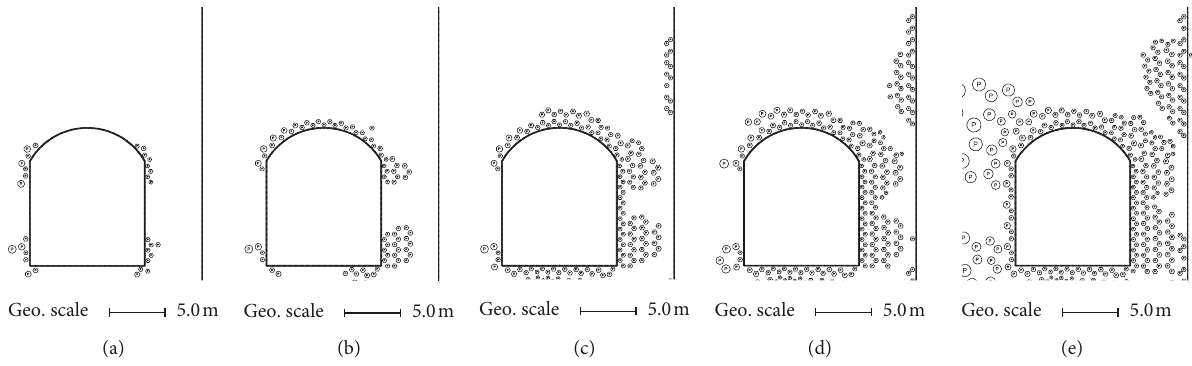
� 1.0; (c) k � 1.5; (d) k � 2.0; (e) k � 3.0. 0 0 0 0